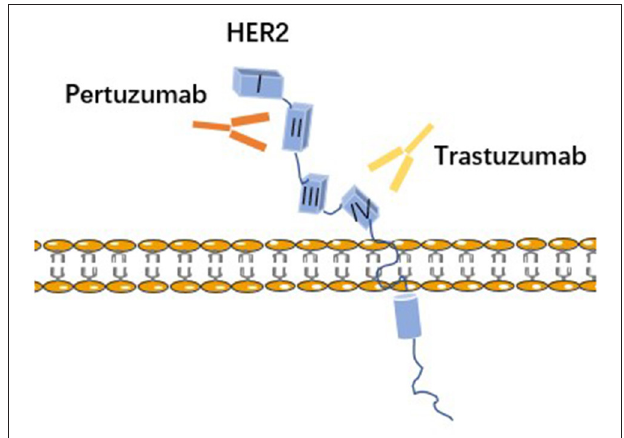
FIGURE 2 | Trastuzumab and pertuzumab bind to different regions on HER2. Trastuzumab is a humanized monoclonal antibody to IV subdomain of HER2. Pertuzumab is a humanized monoclonal antibody to subdomain II of the dimerization arm of